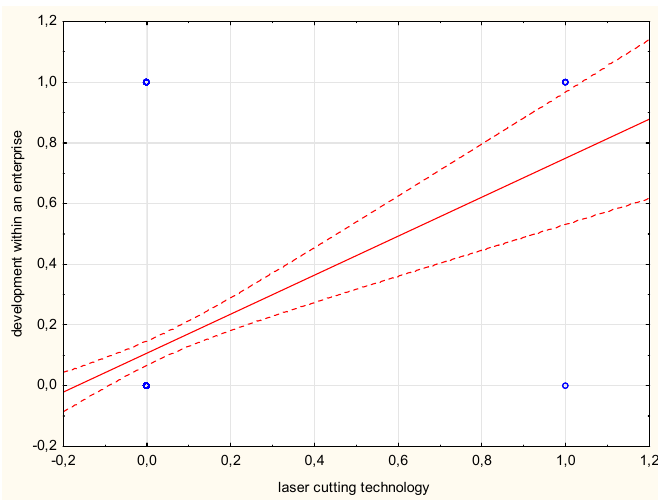
Figure 9. Interactions between the use of laser cutting technology and the future possibilities for increased development within an enterprise.